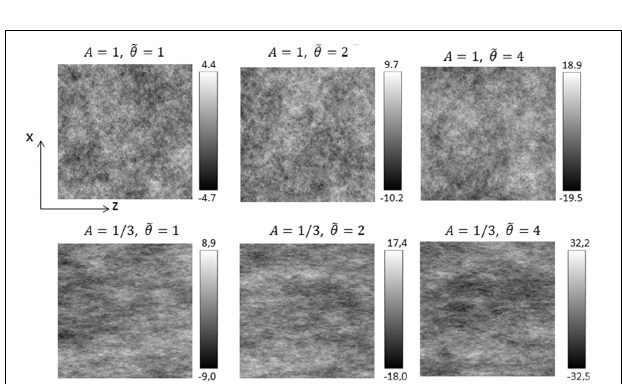
FIGURE 7 | Effect of the system size N and disorder strength ˜ η on the mean size and duration of avalanches. Top, inset: Mean avalanche size (cid:4) S (cid:5) as a function of c for constant k = 10 − 2 and (A) different N at constant ˜ η = 1 and (B) different ˜ η at constant N = 1024. Bottom, inset: Mean avalanche duration (cid:4) D (cid:5) as a function of c and constant k = 10 − 2 and (A (cid:6) ) different N and constant ˜ η = 1 and (B (cid:6) ) different ˜ η and constant